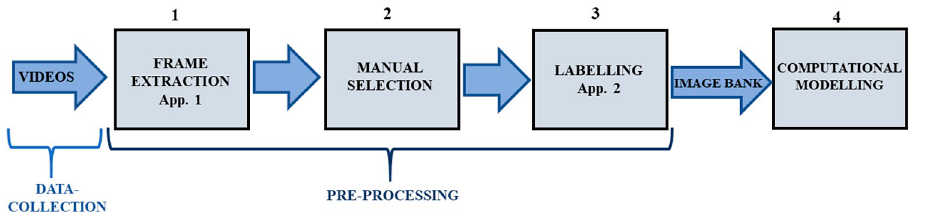
Fig 1. Methodology steps for building the machine vision algorithm for pain assessment in